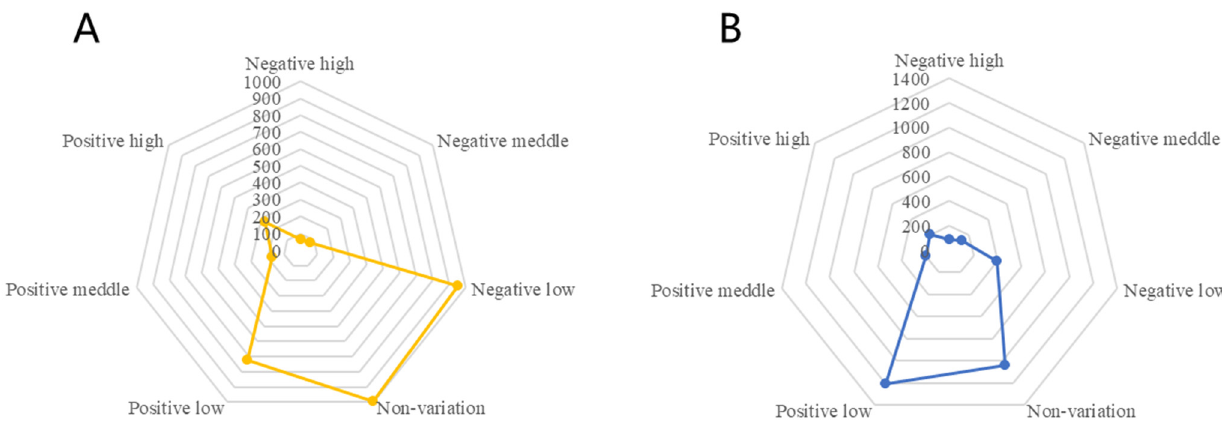
Figure 5. The proportion of matching modes distribution between 2009 and 2018 (( A ): cultivated land, ( B ): rural residential land). Table 3. The proportion of matching modes distribution between 2009 and